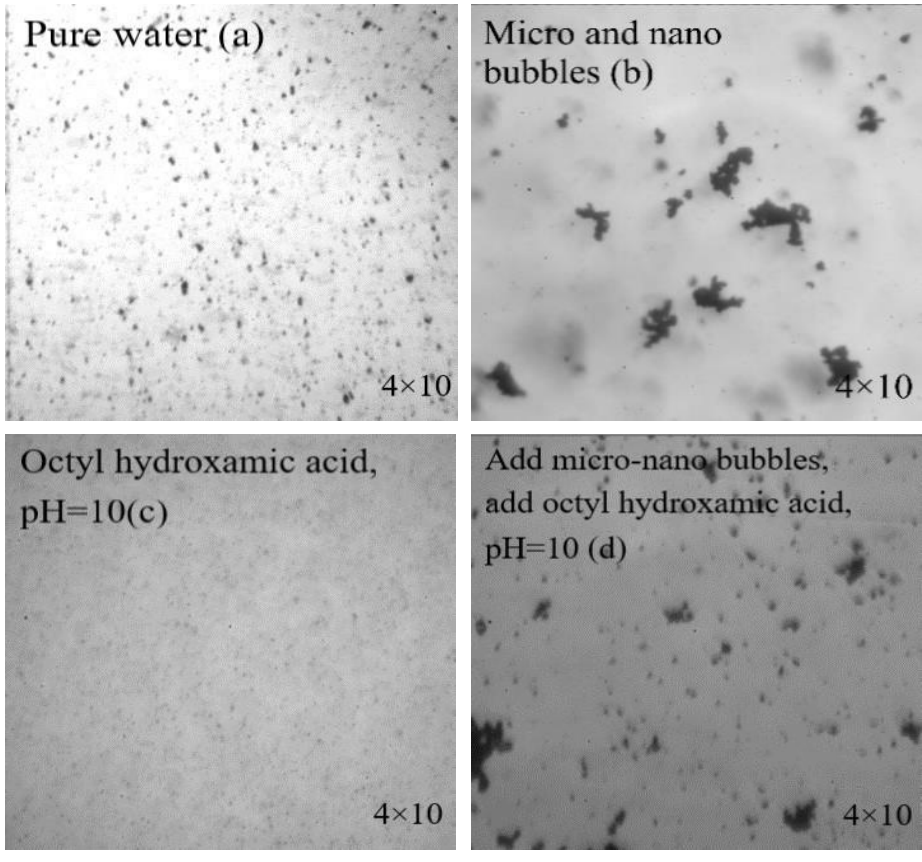
Figure 8. Agglomeration of ore particles under different conditions. ( a ) pure water, ( b ) micro and nano bubbles, ( c ) octyl hydroxamic acid, pH = 10, ( d ) add micro-nano bubbles and octyl hydroxamic acid, pH = 10.